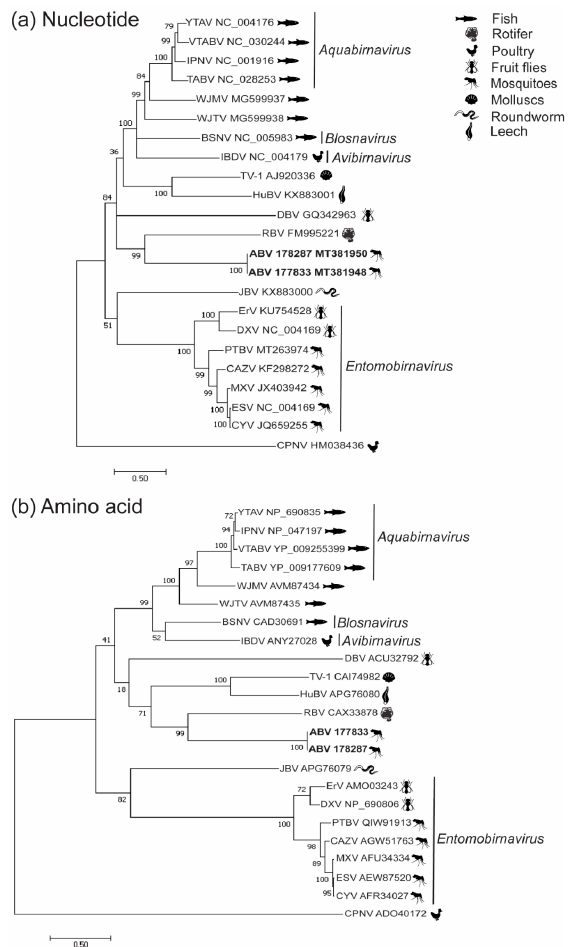
Figure 2. Phylogenetic analysis of ABV VP1. Unrooted maximum likelihood trees constructed from ( a ) VP1 nucleotide coding sequences (CDS) aligned using the MUSCLE algorithm and ( b ) VP1 amino acid sequences aligned with MAFFT . The broad host-species classification for each virus is indicated by icons next to the virus name. Currently recognized genera are indicated in italics. Maximum likelihood analyses were performed in MEGA 7.0.26 using the general time-reversible (GTR) model with gamma distribution (5 categories ( + G, parameter = 1.8479)) and invariable variation for some sites ([ + I], 2.92% sites) for nucleotide sequences and the Jones–Taylor–Thornton (JTT) model with gamma substitutions and no deletions for amino acid sequences.